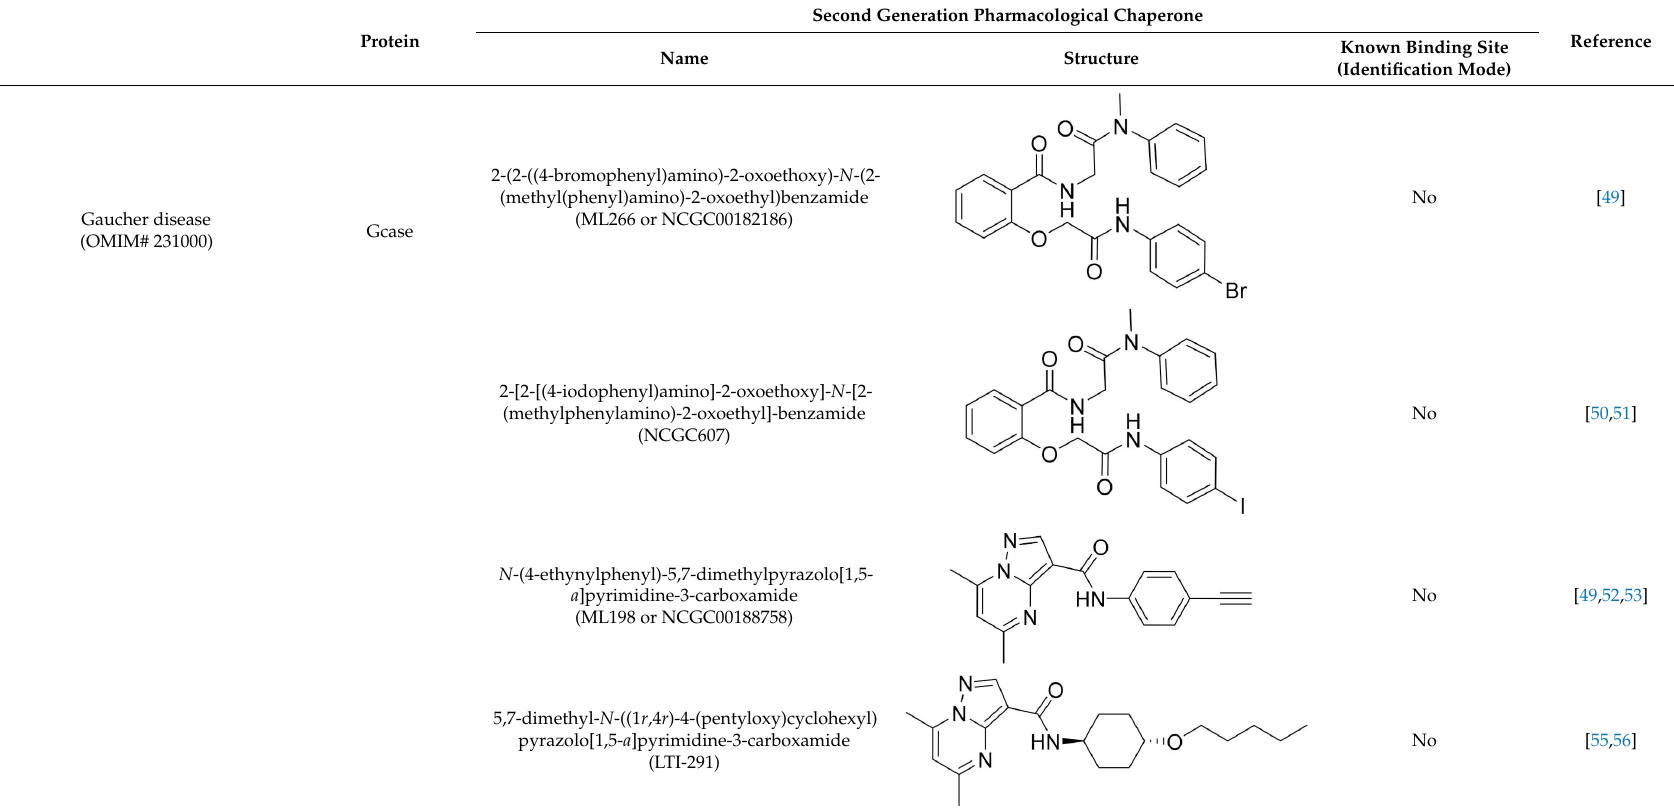
Table 1. Summary of the diseases due to enzyme misfolding for which a non-inhibitor pharmacological chaperone has been